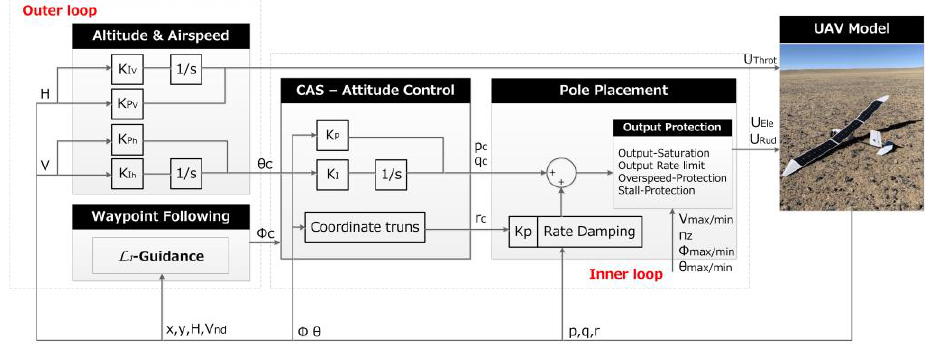
Figure 8. Cascaded control scheme for solar-powered UAV.